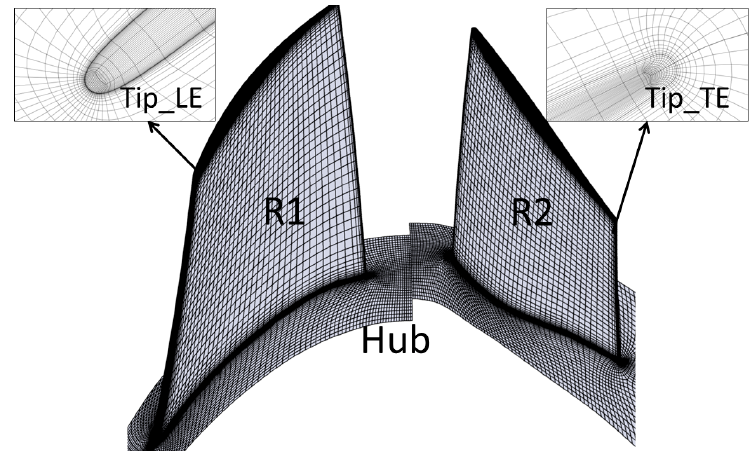
Figure 3. The computational grid of the two rotors.